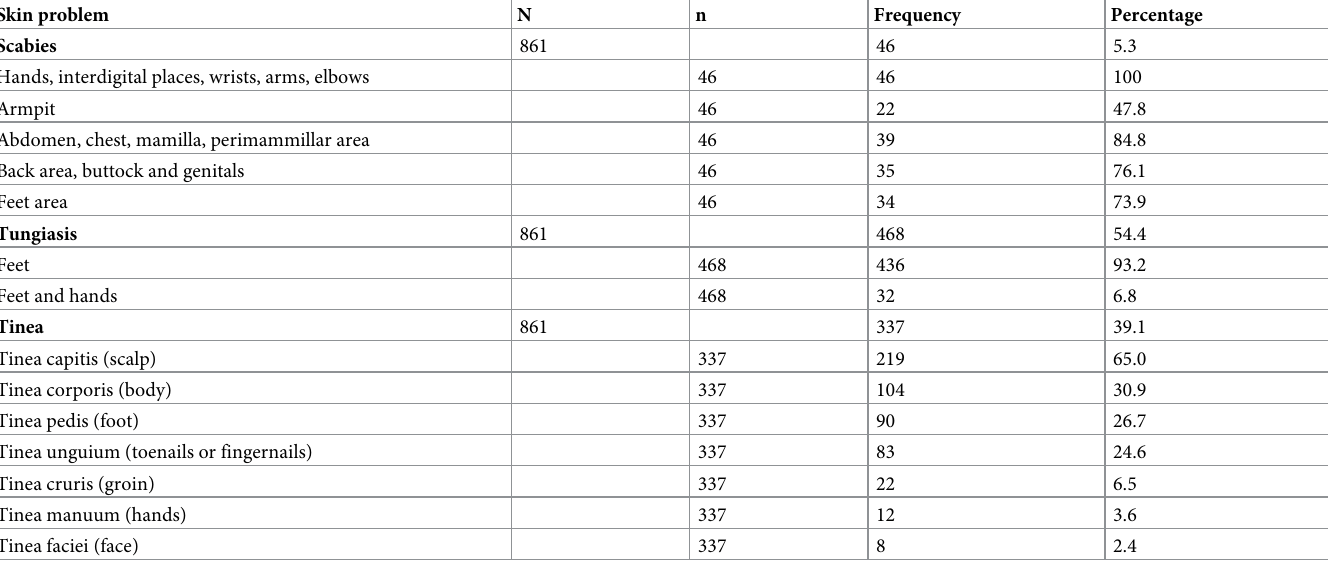
Table 1. Distribution of scabies, tungiasis, and tinea infections among schoolchildren in the Wonago district, southern Ethiopia, 2017. Skin